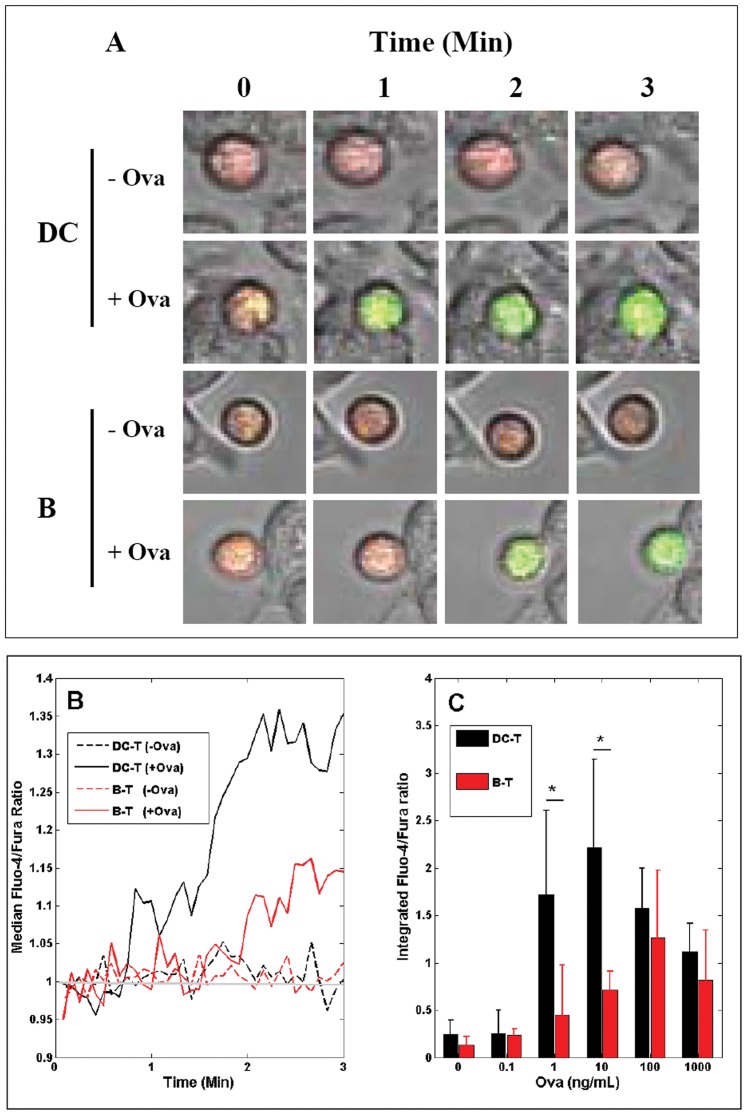
Calcium response of T-cells bound to APCs.(A) Representative differential interference contrast (DIC) images of the DC:T-cell or B:T-cell conjugates overlaid with the Fluo-4 (green) and Fura-red (red) fluorescent signals (loaded in T-cells only) at the indicated time points. DCs or B-cells were pre-pulsed or not with Ova peptides (10 ng/ml) for 4 h prior to co-culture with T-cells. (B) Time course of intracellular calcium concentrations in the responding T-cells, as measured by Fluo-4/Fura-red ratio. Each plot represents data from a pair of cell:cell conjugates. (C) Average calcium response of T-cells bound to DC (black) or B-cell (red) pre-pulsed with Ova peptides at different concentrations (0.1 ng–1 µg/ml). To quantify early calcium response in T-cells, Fluo-4/Fura-red ratios were measured every 5s in responding T-cells and were then integrated for 3 min from the time of the initial calcium increase (grey line, Fig 4B). For each condition, the average calcium response was measured by pooling data of APC:T-cell conjugates (n>15 pairs of cells) from >3 independent experiments. Bars indicate mean ± s.e.m. *p<0.01, unpaired t-test.